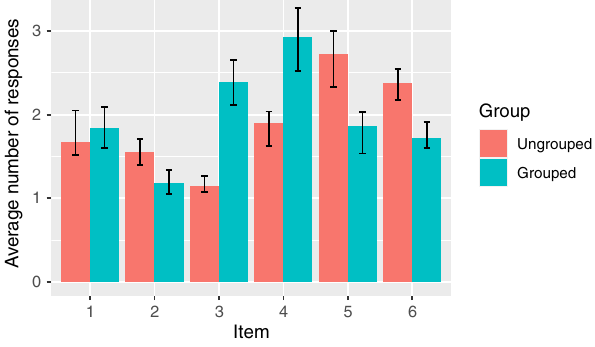
FIG. 4. Average number of answer choices selected online by Institution 1 students for the six MCMR PIQL items with items grouped or ungrouped.